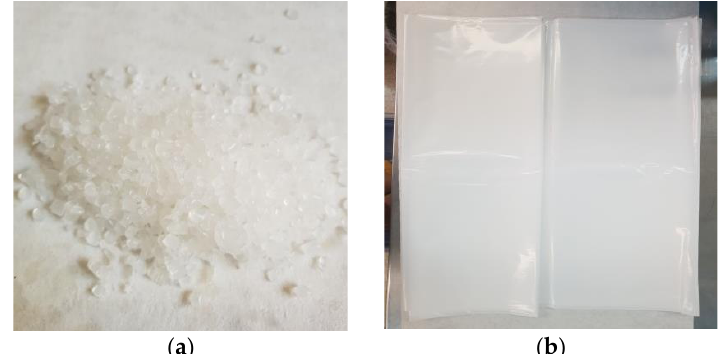
Figure 1. Presentation of ( a ) the pellets of the encapsulated tomato leaves – stem extract in LDPE and ( b ) the final polymeric film with 1% bioactive compounds.